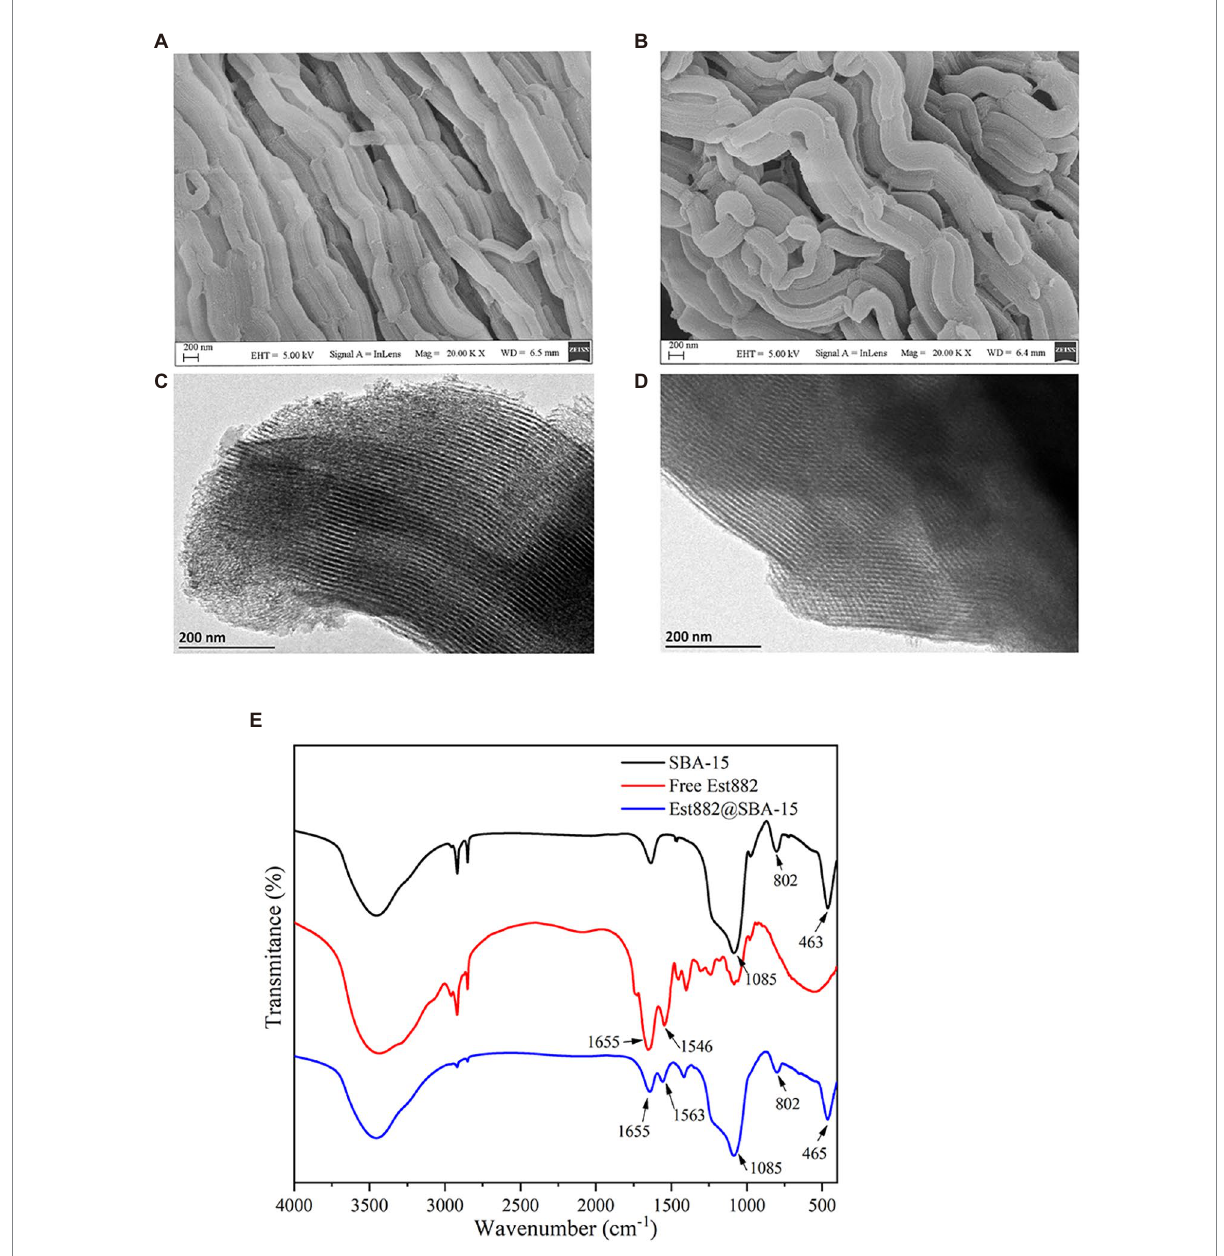
FIGURE 7 SEM (A,B) , TEM (C,D) , and FTIR (E) of SBA-15 immobilized